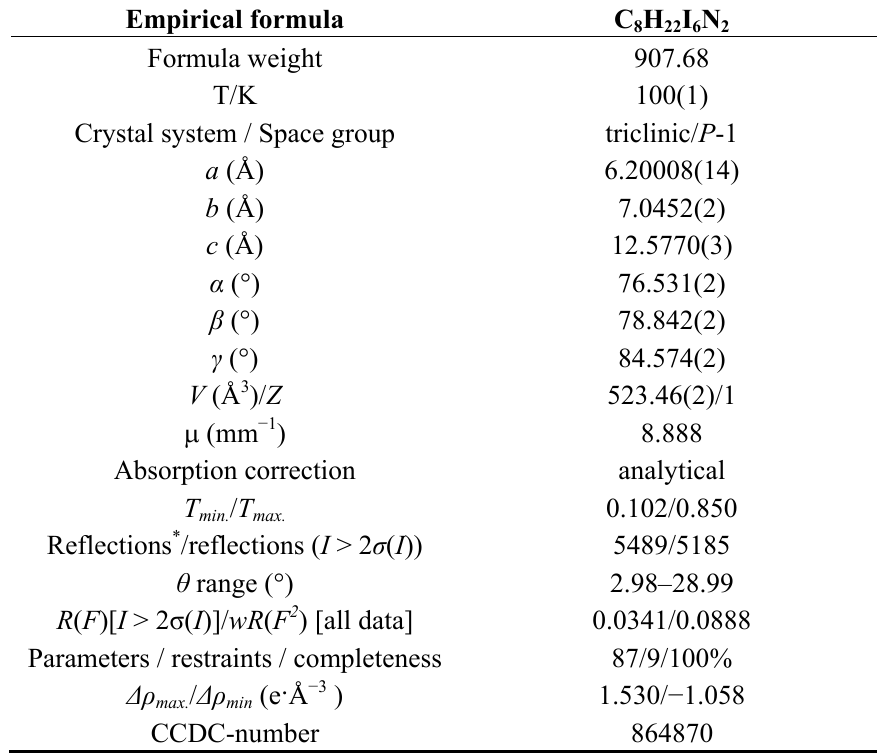
Table 3. Crystallographic data for the title